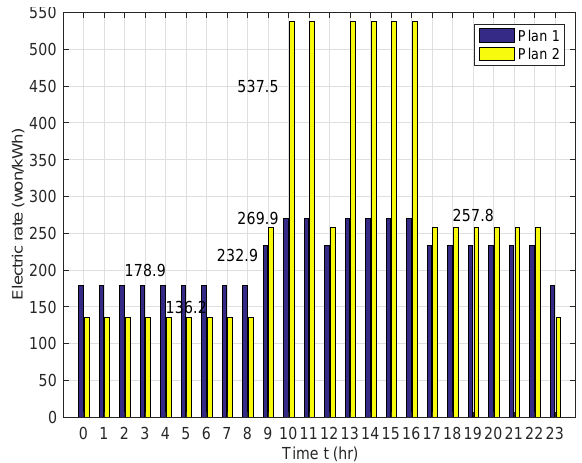
Figure 3. Examples of the slow-rate plan r ( t ) (KRW 1000 is USD 0.83).